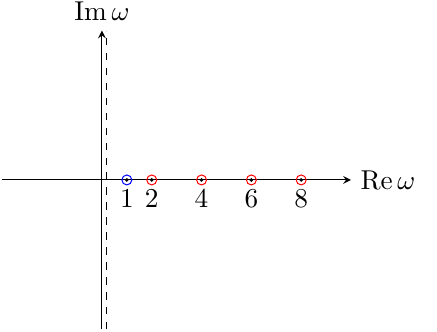
Figure 13. A trick [11] to simplify the expressions by using the symmetrized kernel.